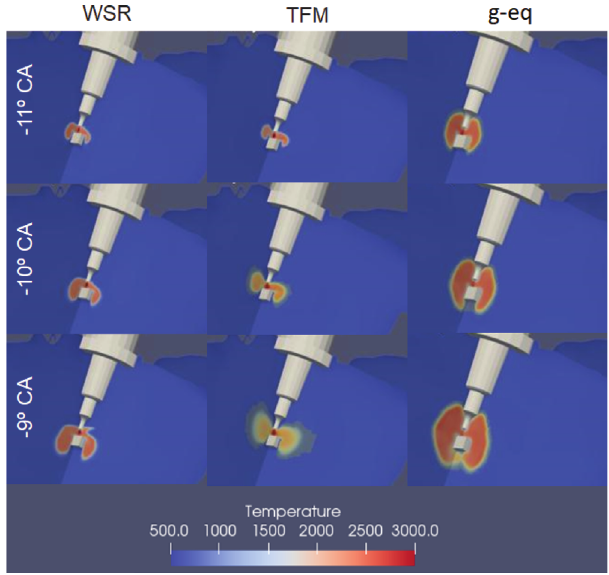
Fig. 18. Kernel growth for the three combustion models and LESI at three times during ignition, for representative